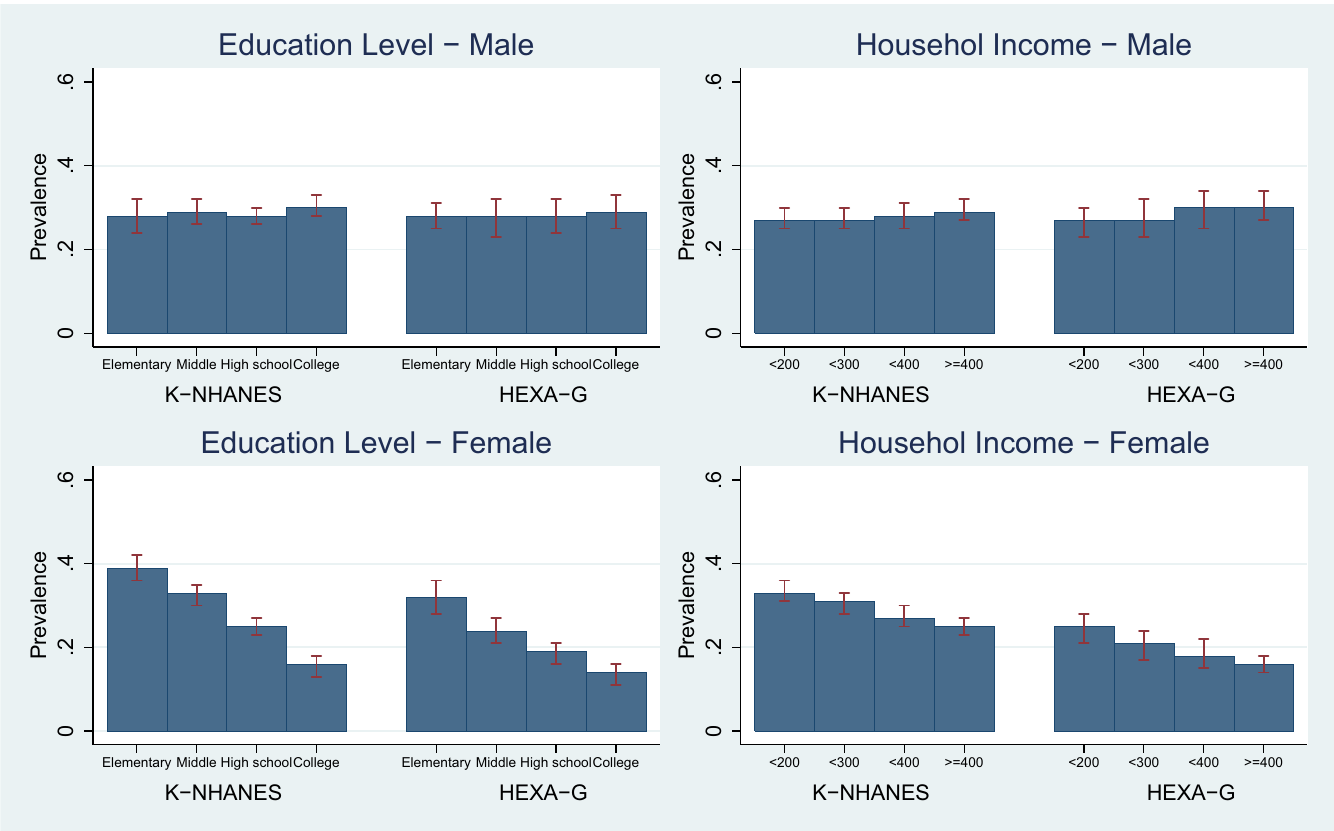
Fig 1. Age-standardized prevalence: Enlarged waist circumference. K-NHANES: Korea National Health and Nutrition Examination Survey; HEXA-G: Health Examinees-Gem. Enlarged waist circumference (cid:21) 90 in males and (cid:21) 85 in females.